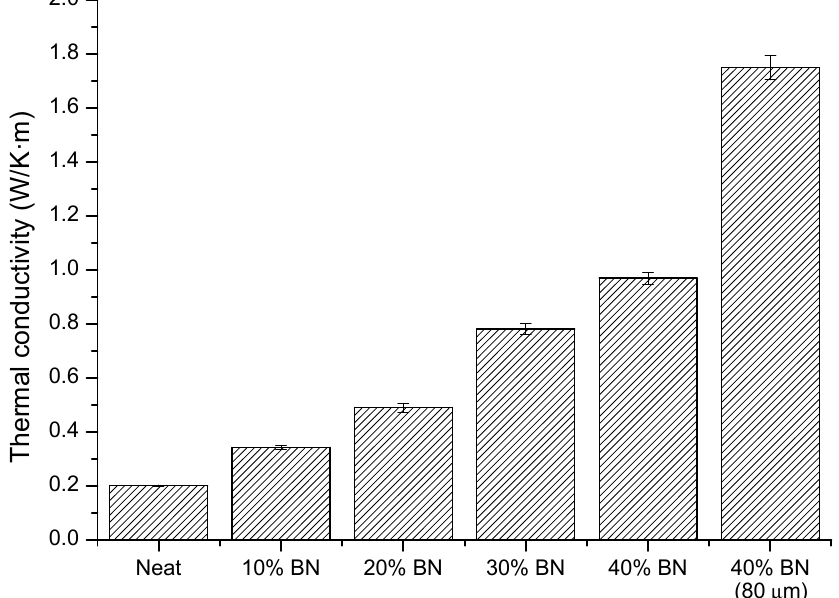
Figure 8. Thermal conductivity of the neat material and composites prepared.